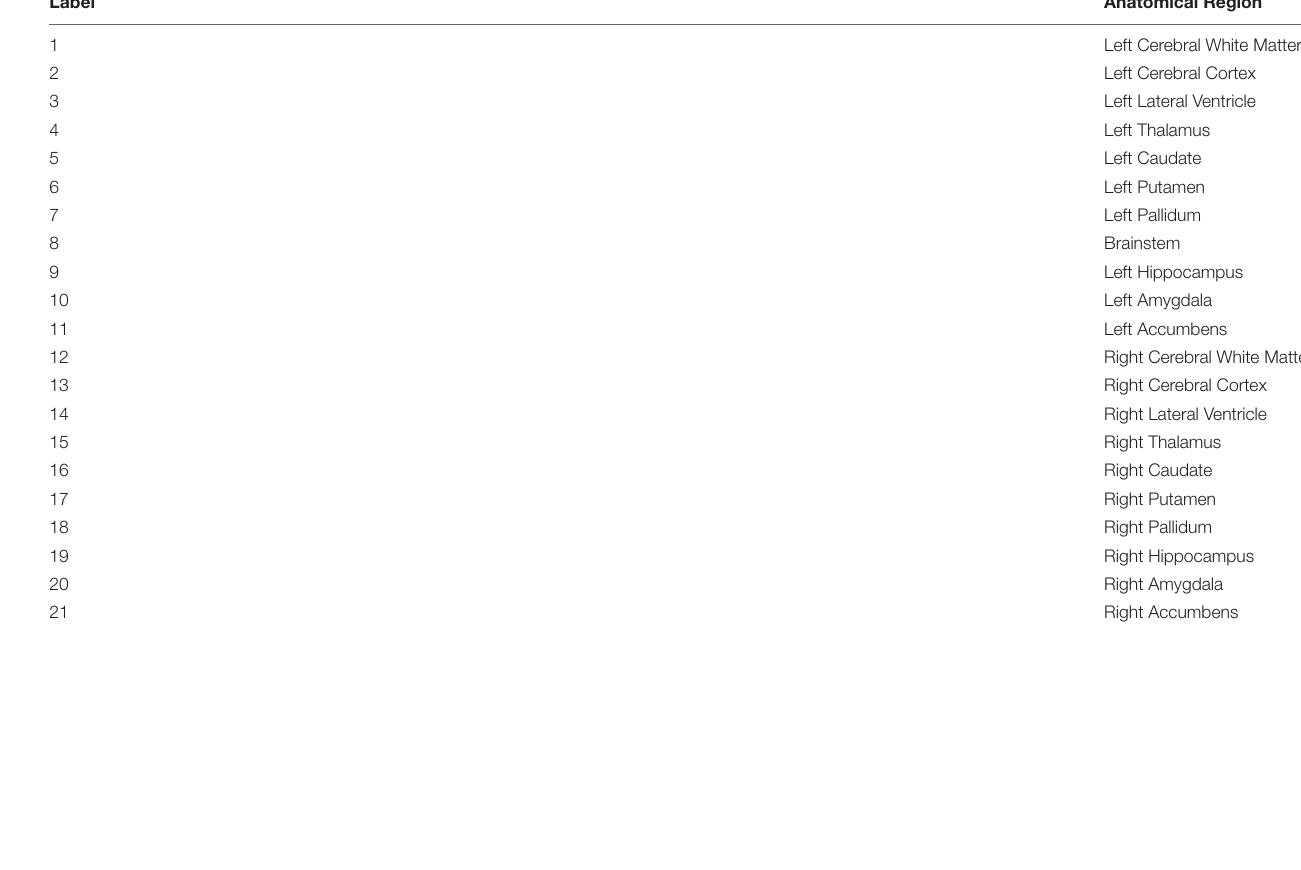
TABLE A1 | The 21 subregions defined by the Harvard-Oxford subcortical atlas are tabulated